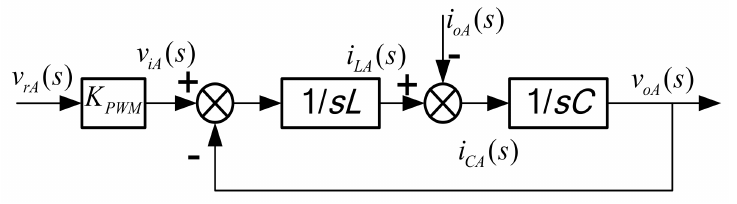
Figure 5. Single phase open loop block diagram of inverter.